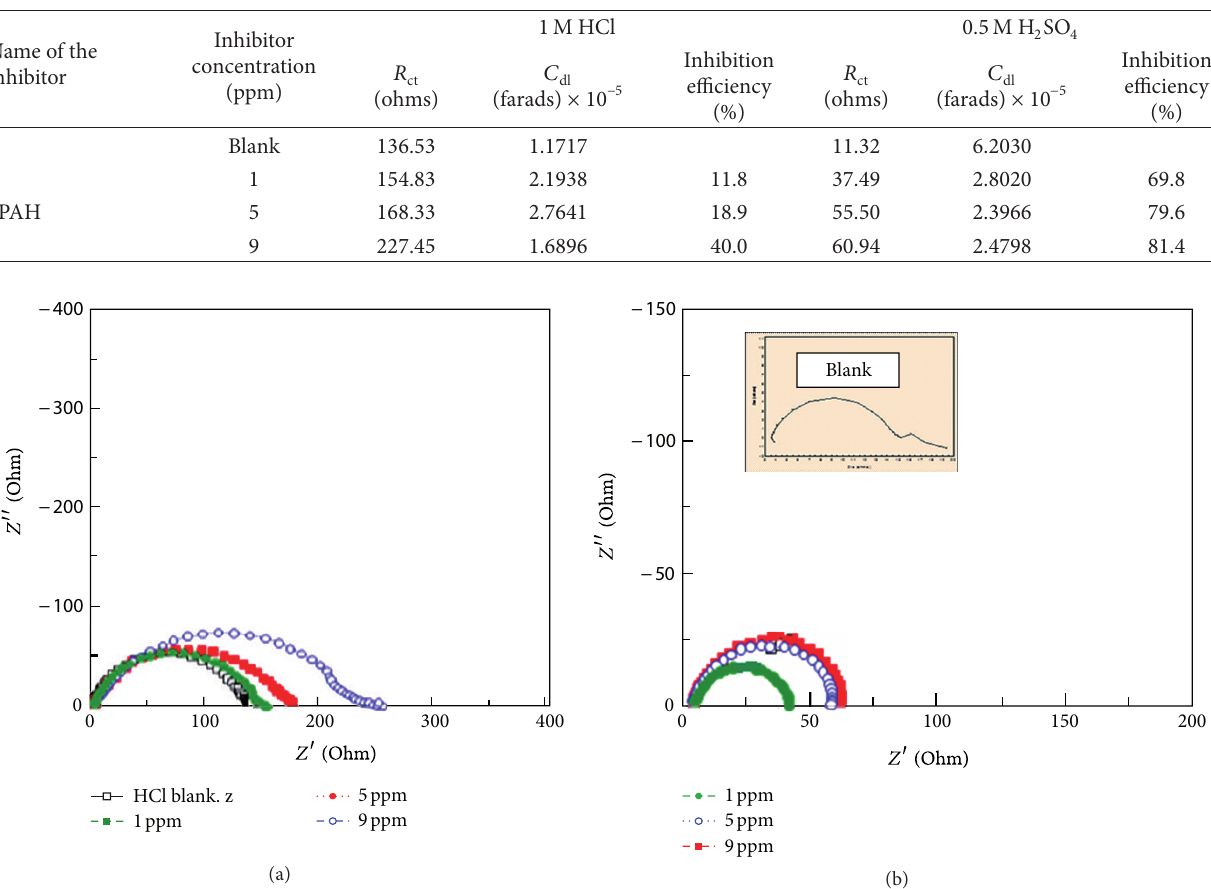
SO with and without 2 4